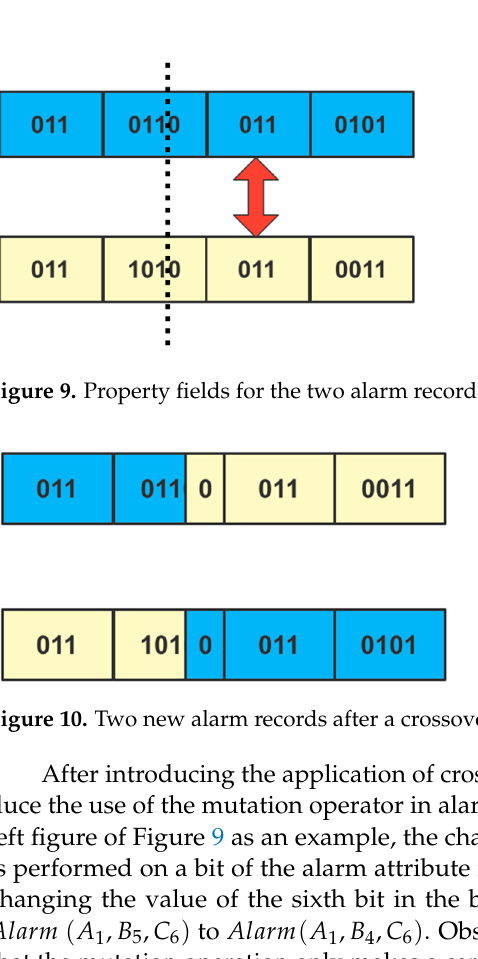
12 of 26 Figure 8. Figure of fitness function (cid:1831) (cid:3021) (cid:1863)(cid:4666)(cid:1872), (cid:1876)(cid:4667) for t = 500. For a cluster center, only considering the number of alarms contained in the cluster center as an evaluation index cannot indicate the quality of the cluster center. Only when the number of alarms contained in the cluster center is large enough and the difference between alarms is small enough do we believe that the selection of the cluster center is reasonable. Therefore, we define a fitness function for the internal differences in the alarm cluster center, as shown in Equation (11). The average depth of the four hierarchical trees as shown in Figure 1 is (3 + 2 + 3 + 2)/4 = 2.5. (cid:1831) (cid:3020) (cid:4666)(cid:1863)(cid:4667) = 1 (cid:1866) (cid:3533) (cid:4678)1 − (cid:1830)(cid:4666)(cid:1829) (cid:3036) (cid:4667) (cid:1839) (cid:3031) (cid:4679) (cid:3041) (cid:3036)(cid:2880)(cid:2869) (11) where (cid:1861) = (cid:4666)1,2,3, … , (cid:1866)(cid:4667) represents (cid:1866) alarms belonging to a cluster center k , (cid:1830)(cid:4666)(cid:1829) (cid:3036) (cid:4667) repre- sents the sum of the distances between the alarm and each attribute of the cluster center in its attribute tree, and (cid:1839) (cid:3031) represents the average depth of all attribute hierarchy trees. 4.3. Crossover and Mutation Operator One of the difficulties of the WOA in solving hierarchical clustering problems is how to apply Equations (2), (6) and (9) to transform search agent positions for different types of attributes. If an attribute is a continuous variable, the use of the above formula is not affected, but if an attribute is a discrete variable then using the formula is difficult. Because we use the attributes of the hierarchical tree structure and type of binary coding structure, we can easily transform the attributes into a hierarchical tree. Here, we use crossover and mutation operators of the genetic algorithm to solve this problem. Another advantage of